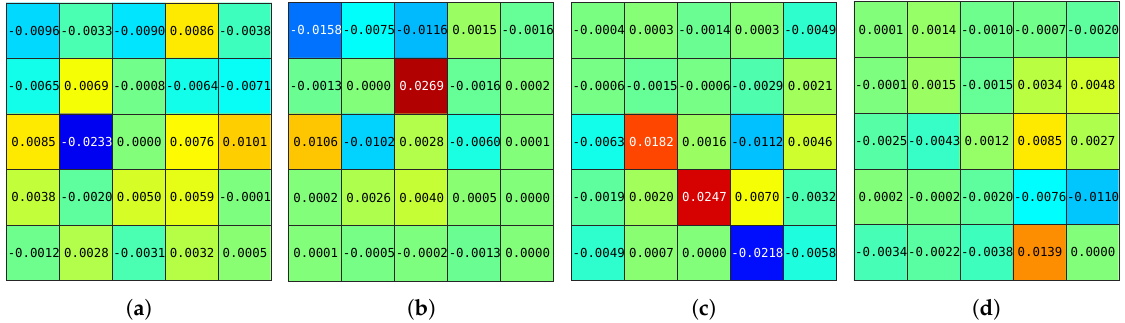
Figure 7. Compared irradiance distribution between the mathematical model and measured values: suitable experimental setup in Table 2 is ( a ) setup #1, ( b ) setup #2, ( c ) setup #3, and ( d ) setup